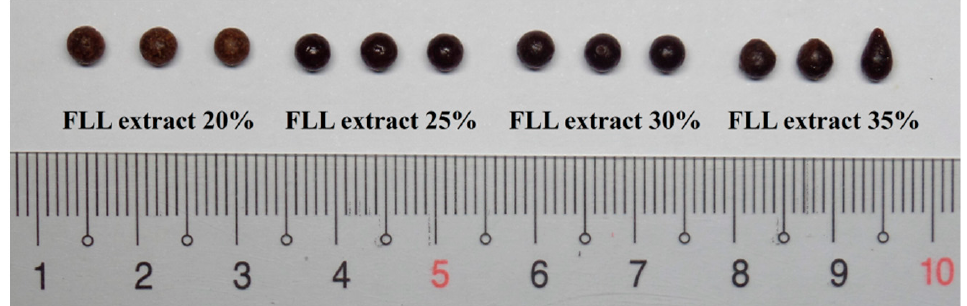
Figure 4. Dropping pills prepared using different amounts of FLL extract. Surfactant Selection